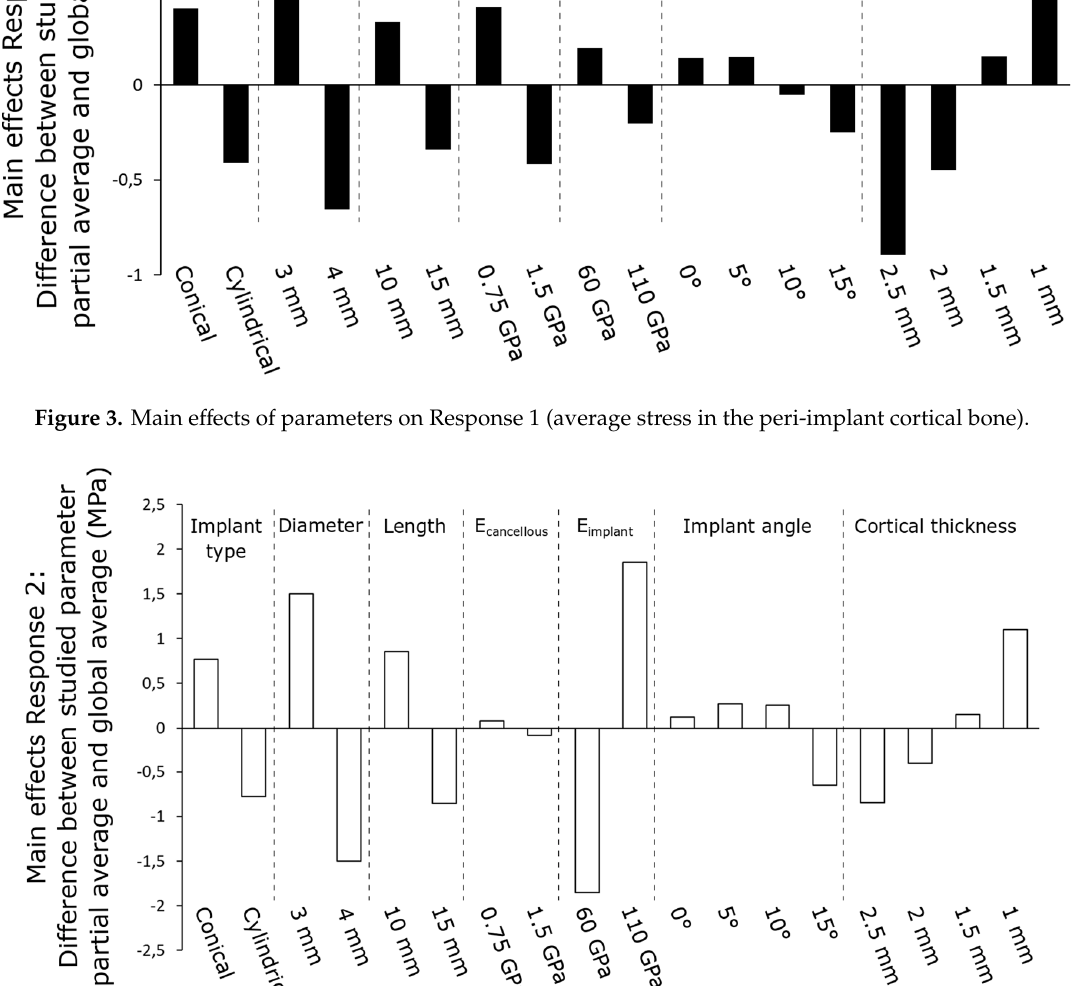
Figure 5. Main effects and first-order interactions between parameters on Response 1.